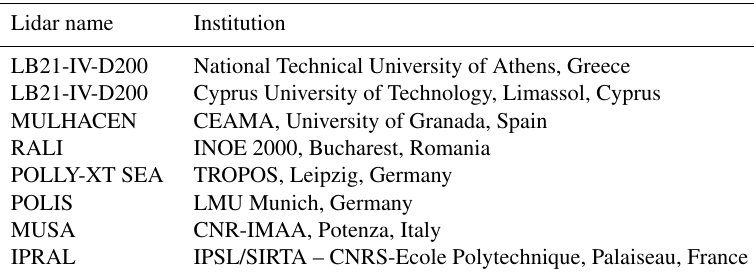
Figure 8. Histogram of the simulated δ values for the synthetic lidar. Dashed lines represent δ r at 0004 (left) and 045 (right) used in the simulations. Table 4. EARLINET lidar systems participating in this